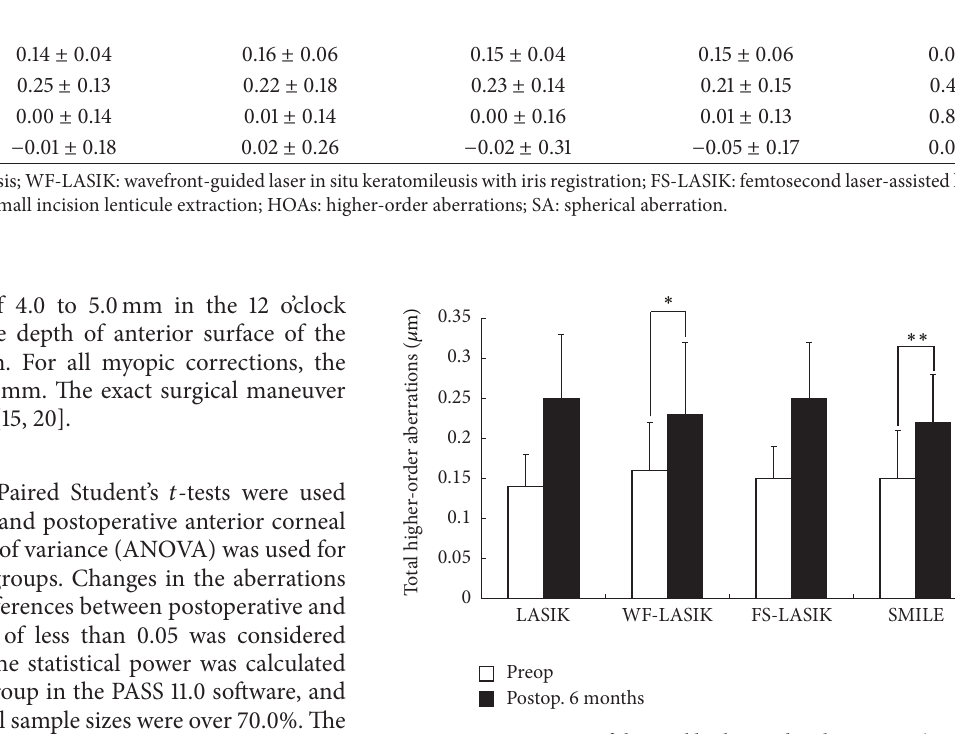
0.49 𝜇 m; SMILE: 0.08 ± 0.18 𝜇 m). For the induced